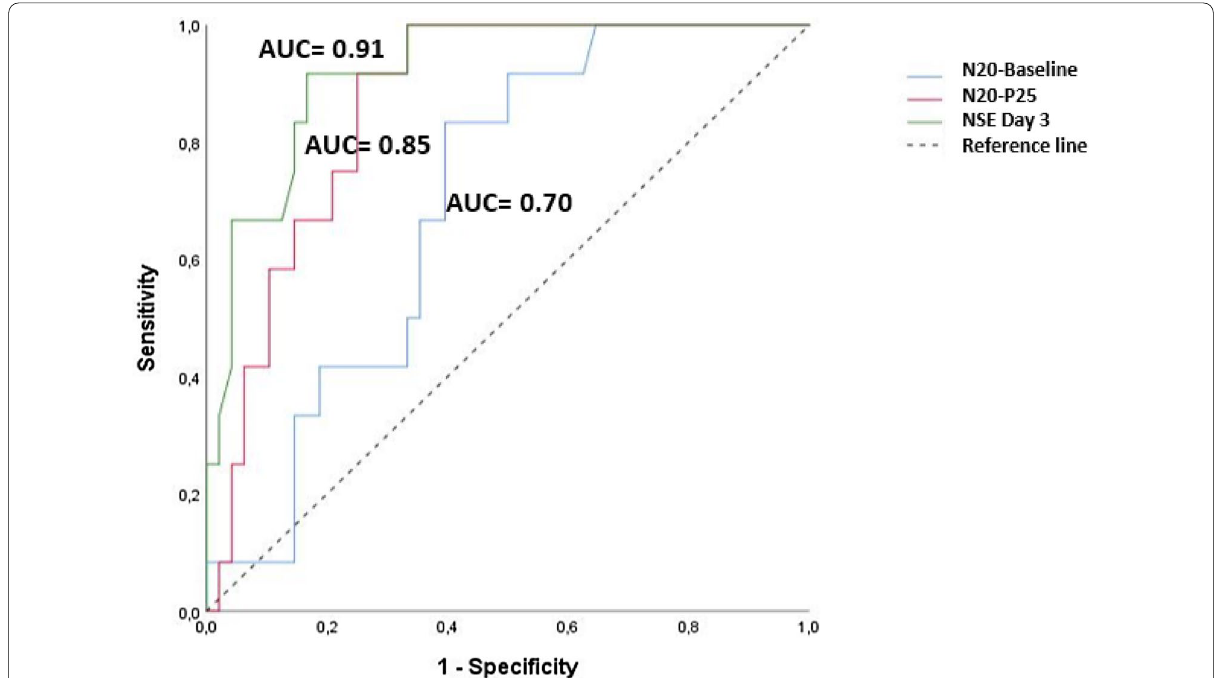
Fig. 3 The receiver operating characteristic (ROC) curves for CPC at 3 months showing the predictive powers of SSEP amplitudes and NSE peak at day 3 after CA. Respective ROC area under curves (AUC) are: NSE at day 3 N20‑baseline 0.70 (0.58‑0.81), p = =